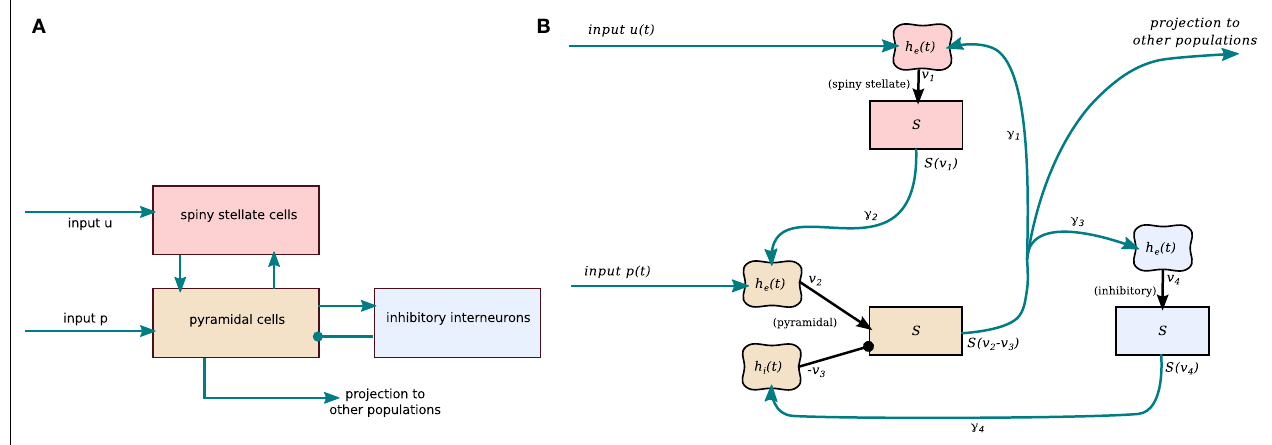
and h i ( t ) model the mean response of excitatory and inhibitory synapse populations respectively, including their postsynaptic dendritic filtering. Sigmoid boxes (denoted S ) represent conversion of mean summed soma membrane potential to mean output firing rate. Connectivity constants γ 1 to γ 4 model the number and strength of connections between